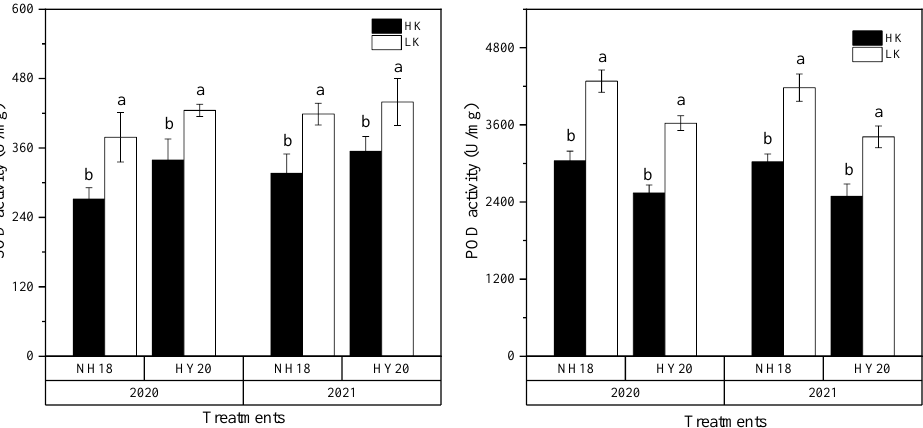
Figure 2. Effects of low K stress on antioxidant enzyme activity in leaves. HK: high K treatment; LK: low K treatment. For the bar chart, a,b indicates a significant difference between different treatments for the same variety ( p < 0.05).